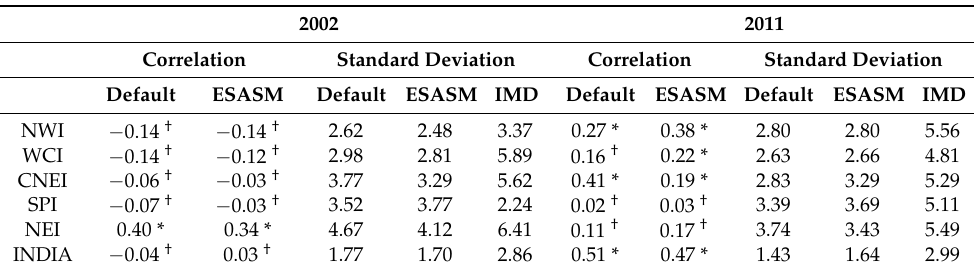
Table 3. Temporal rainfall statistics (mmday − 1 ) from default, ESA configuration and IMD data over the whole of India and five homogeneous regions for the years 2002 and 2011. *: significant at 95%; †: not significant at